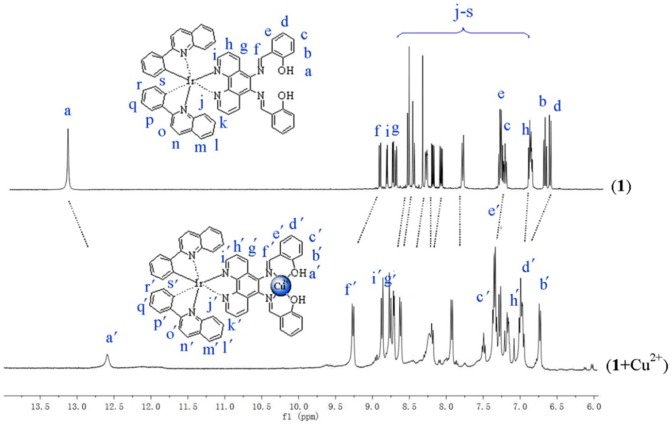
The proposed structure for 1-Cu2+, and 1H NMR spectra of 1 (5 mM) and CuCl2 (5 mM) in DMSO-d
6.